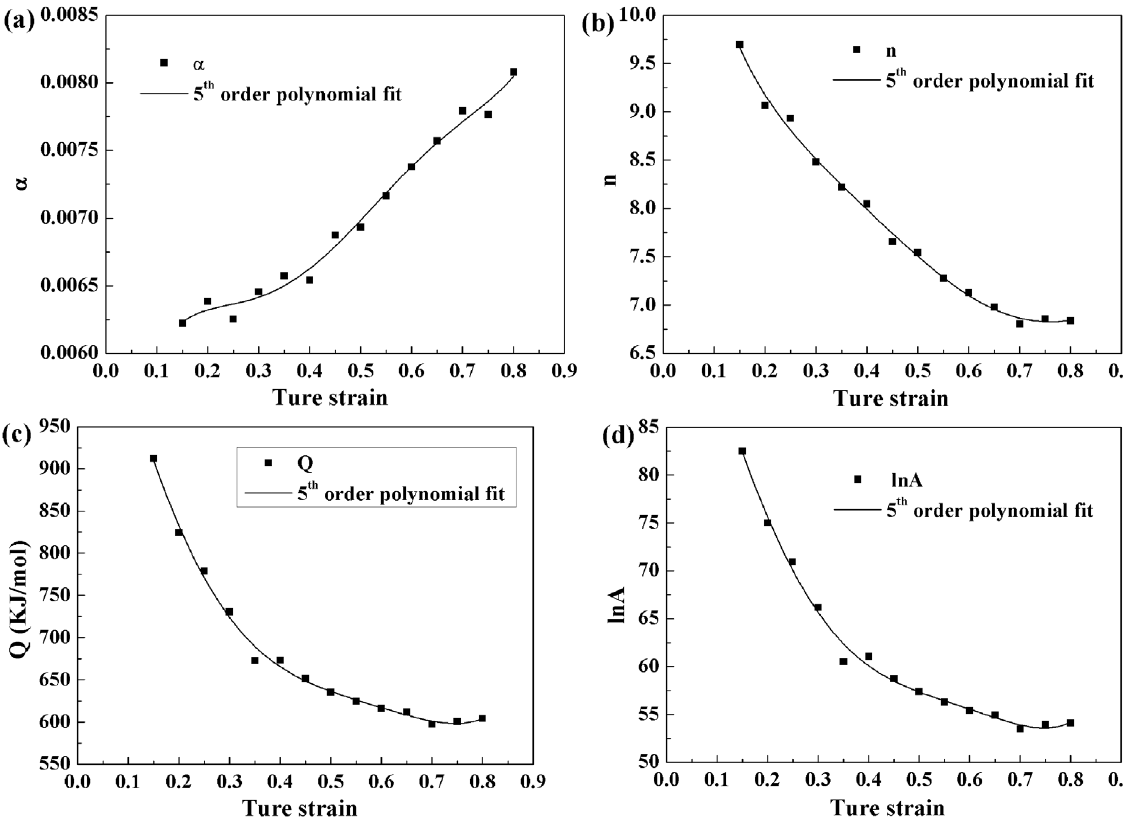
Fig. 5: Variation of (a) α , (b) n , (c) Q , (d) ln A with true